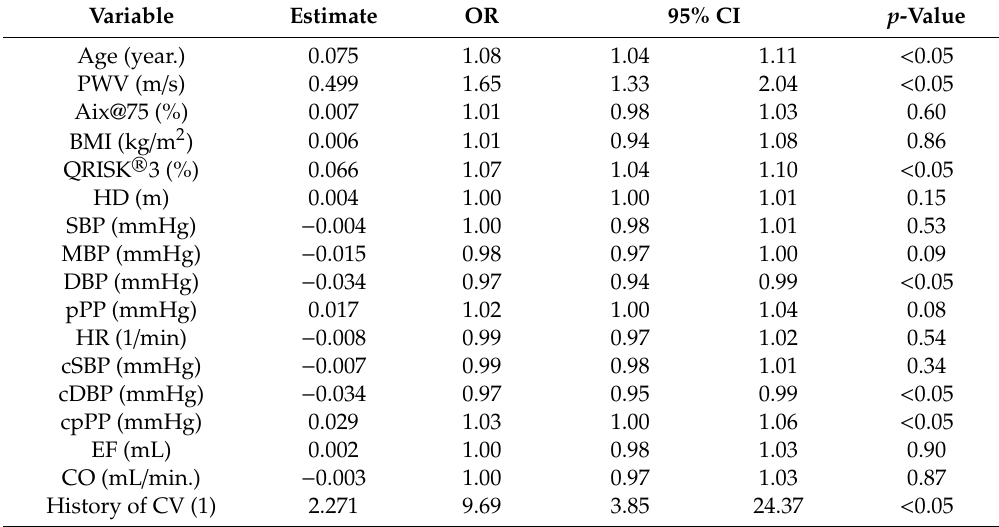
Table 4. Univariate logistic regression. Variables correlated to dependent status (Barthel index < 80 points). Variable